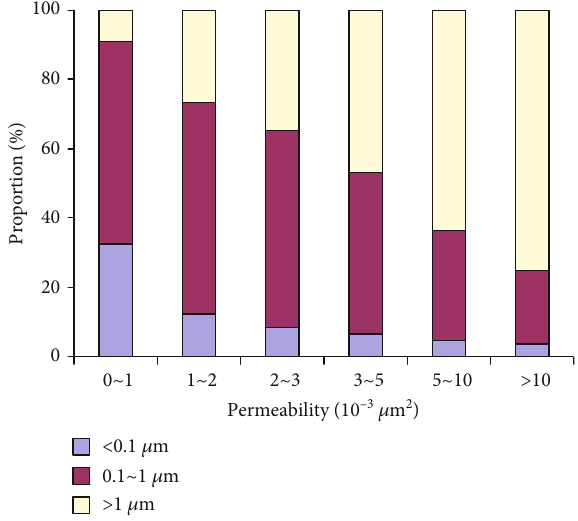
Figure 3: Distribution ratios of the di ff erent types of throats in the di ff erent low-permeability cores.